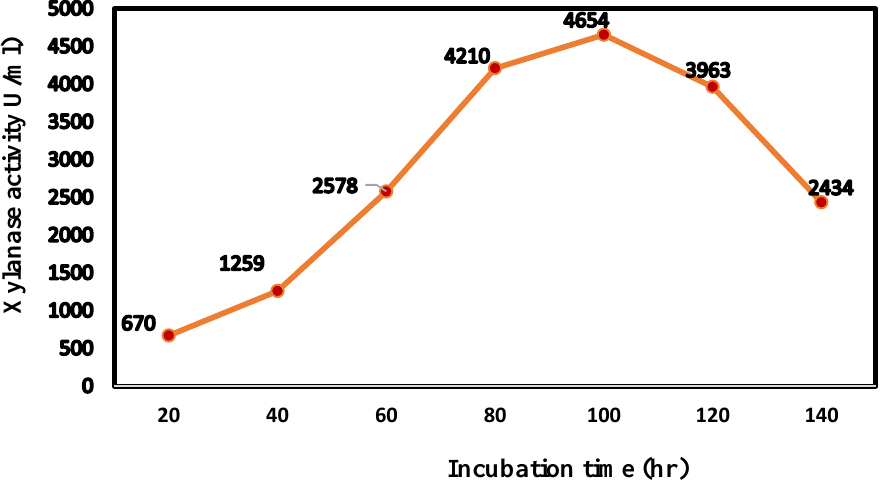
Figure 11. Xylanase activity profile in the bioreactor.